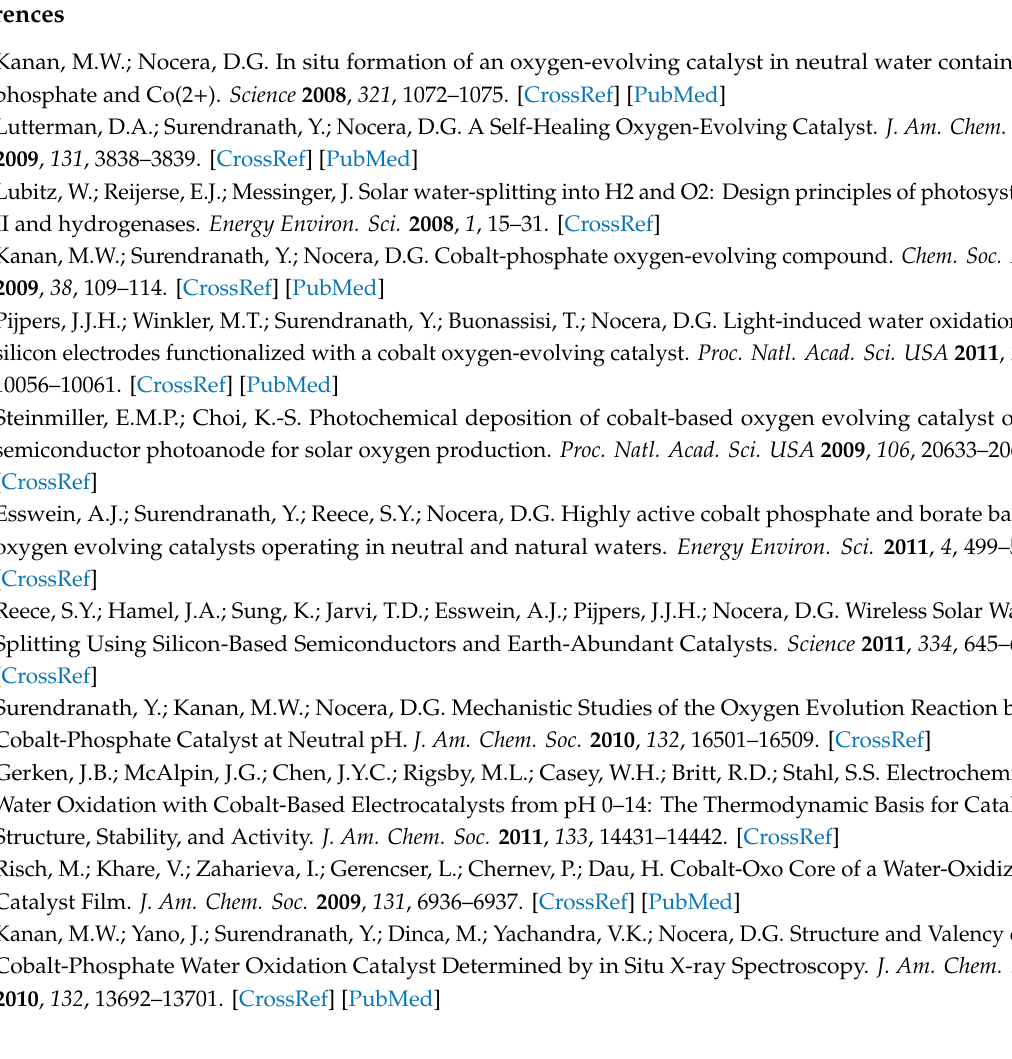
Figure S1: Bottom two traces of Figure 3A: EPR spectra of a Co-Pi modified Au electrode electrolyzed at the highest applied potential of 1.7 V, recorded before (top) and after (bottom) the electrolyte solution exchange. P MW = 63 mW, T = 5 K, Figure S2: EPR spectra of the electrolyte solution used in the titration series measured at several MW power levels. The narrow g ≈ 2.1 line is found in the solution measured separately from the cell, Figure S3: (A) The loss of the Co(II) species and (B) the increase in the Co(IV) EPR intensity as a function of applied potential above the water oxidation